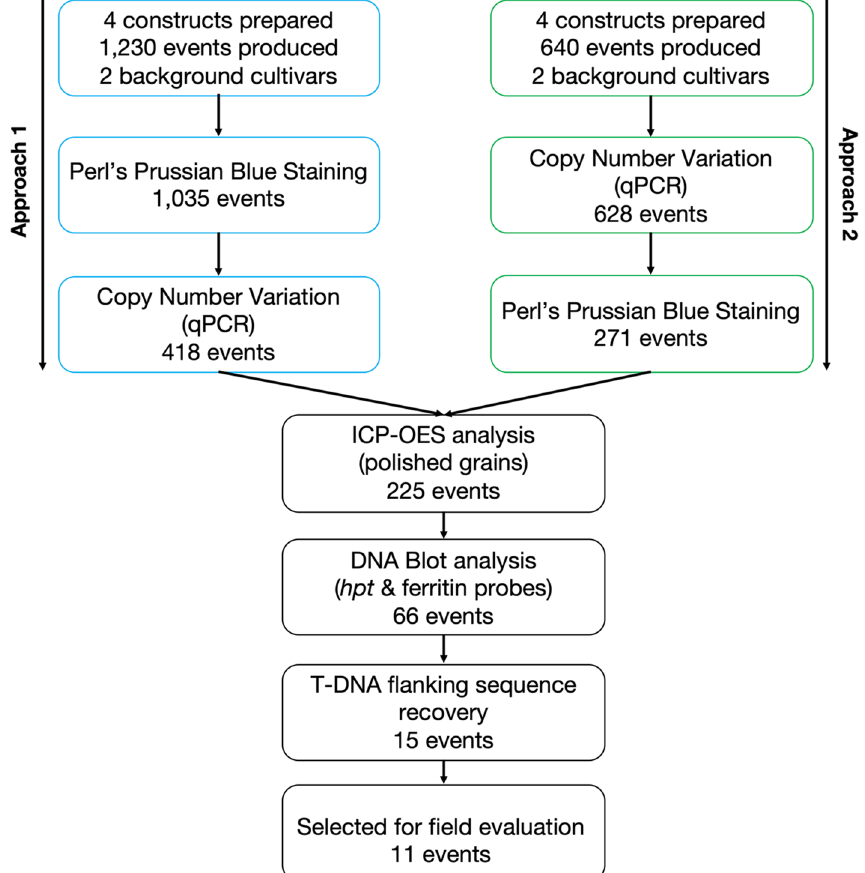
Figure 3. General overview of the study. In total one thousand eight hundred and seventy events were prepared from eight constructs and analyzed for high Fe and Zn in polished rice grains. Eventually eleven events that fulfilled the prerequisites for product development (high Fe and Zn content, good agronomic performance under screen house settings, simple molecular structure, and no transfer of T-DNA beyond the border sequences) were selected for further evaluation under field settings. The whole duration of the process lasted for approximately 1.5 years. hpt : hygromycin selectable marker; ICP-OES: inductively coupled plasma